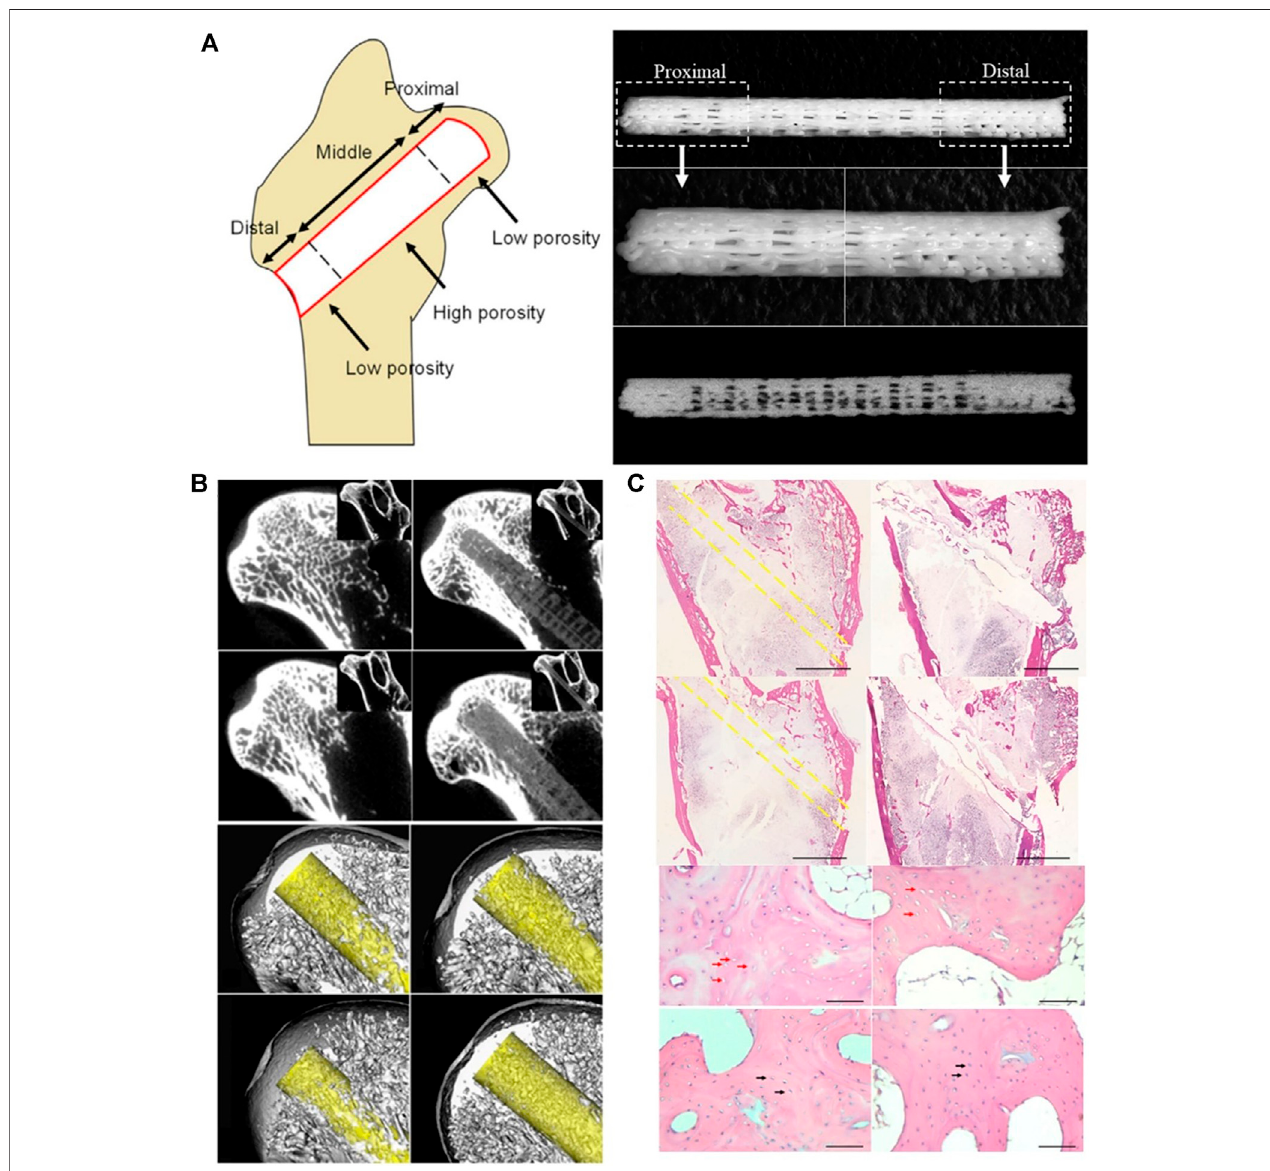
FIGURE 7 | FGS and FGS/BMMC could promote bone regeneration in the area of osteonecrosis. (A) A schematic image shows how the three segments of FGS with different porosities are distributed in the femoral head. The FGS consisting of three segments of spatially graded porosity, including 4 mm length proximal segment of 15% porosity, 17 mm length middle segment of 40% porosity, and 6 mm distal segment of 15% porosity. (B) FGS is degraded at the proximal end, and there is mineralized tissue around it. (C) Histological analysis con fi rmed that there was more new bone formation around FGS than other groups. Reproduced